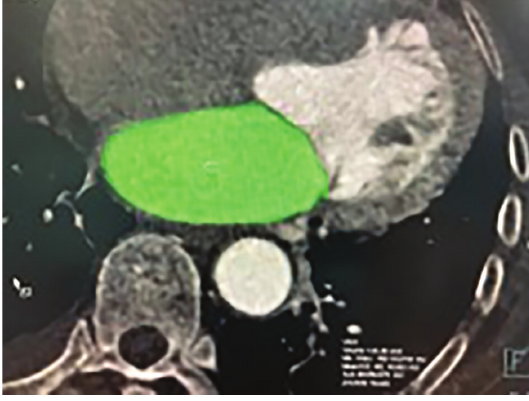
Figure 1 - A calculation of the volume of the left